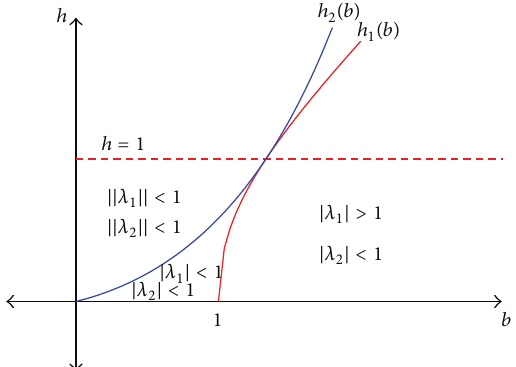
Figure 2: This figure illustrates the magnitude of the eigenvalues associated with 𝑧 1 in the (𝑏,ℎ) -plane. ‖ ⋅ ‖ denotes the magnitude when the eigenvalue is nonreal, while | ⋅ | denotes the magnitude when the eigenvalue is real. ℎ 1 (𝑏) = 1 − 𝑏 + 2 √𝑏(𝑏 − 1 ) comes from the condition 𝑁 = 𝑀− 1, and ℎ 2 (𝑏) = 𝑏( 4 + 3 𝑏)/ 4 ( 4 −𝑏) comes from the condition 𝑀 2 − 4 𝑁 =